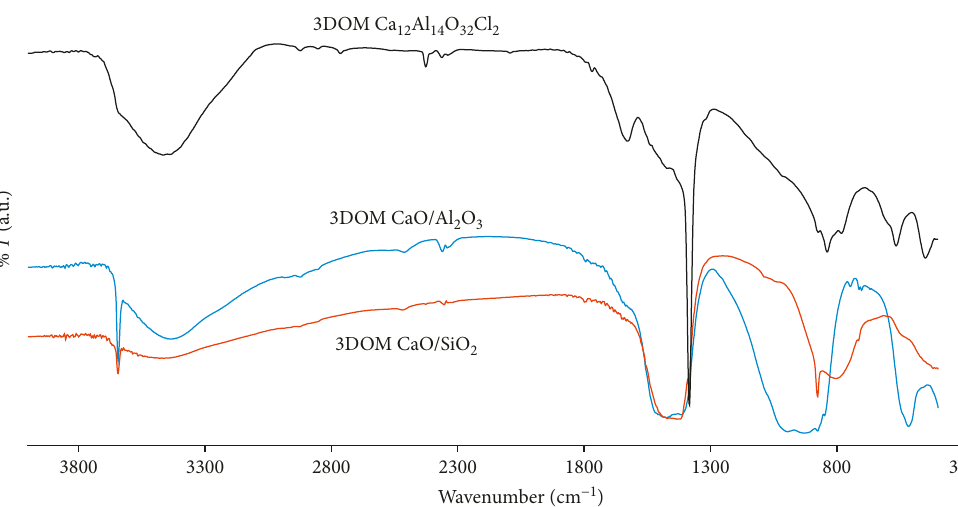
Figure 5: FTIR spectra of the 3DOM CaO/Al